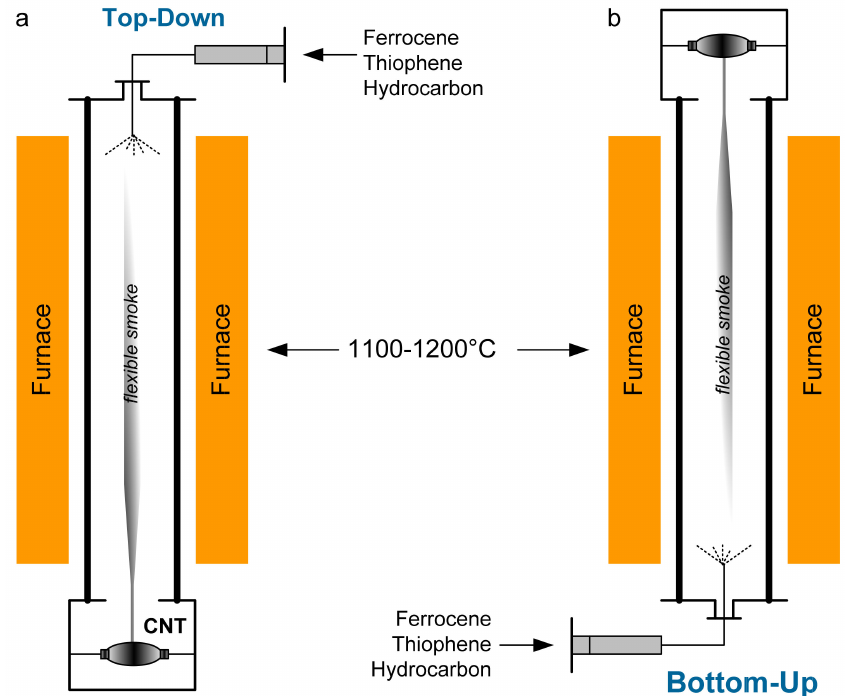
Figure 1. Schematic drawing of a laboratory reactor block for the synthesis of nanotubes with in situ winding: ( a ) top-down “Cambridge Process” [14]; and ( b ) bottom-up “Moscow Process”